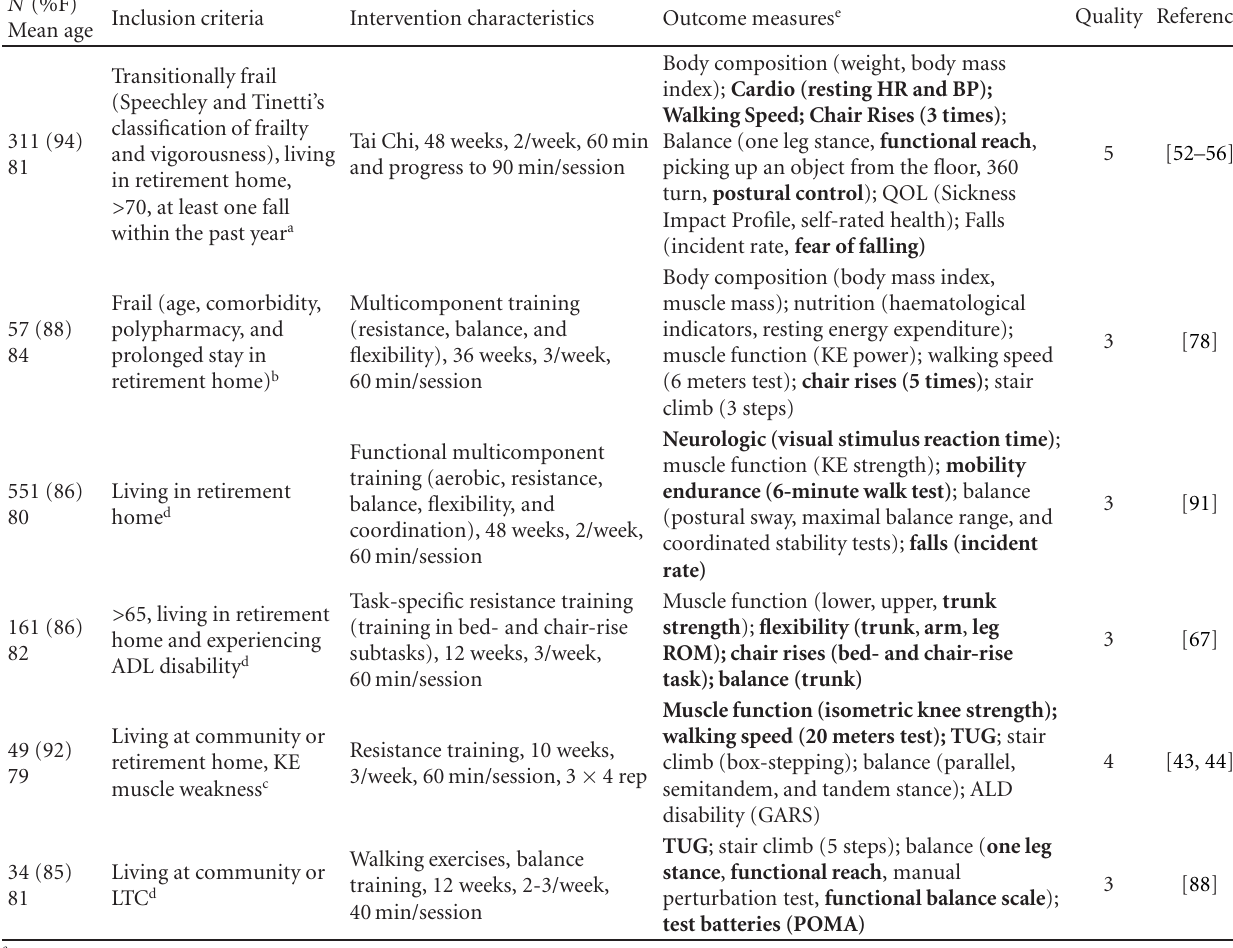
Table 3: Description of studies that were done in retirement homes and in mixed